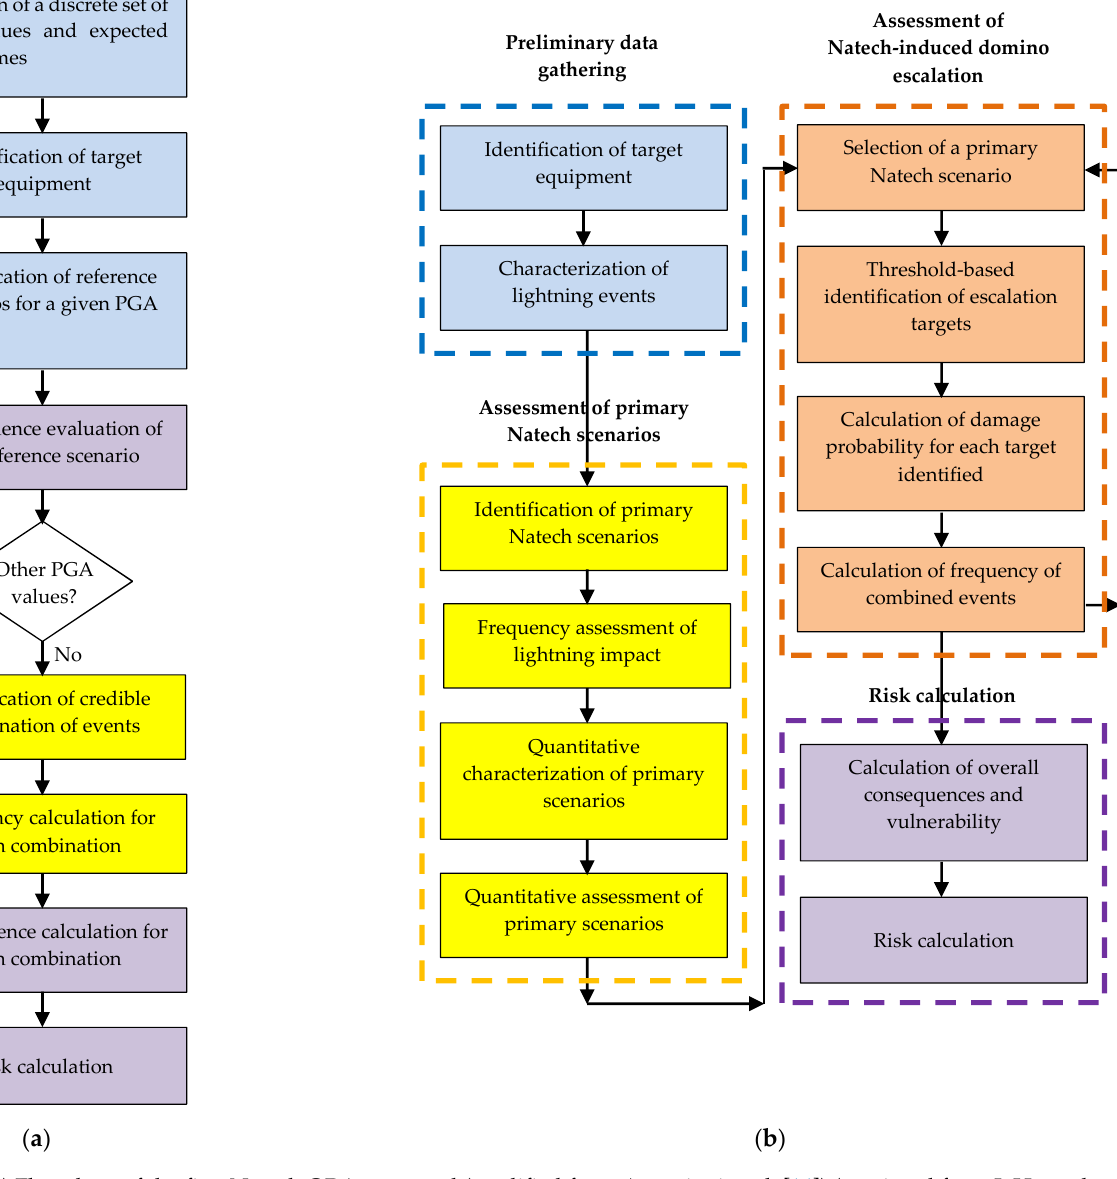
Figure 1. ( a ) Flowchart of the first Natech QRA proposed (modified from Antonioni et al. [14]) (reprinted from J. Hazard. Mater, 147, Antonioni, G., Spadoni, G., Cozzani, V. A methodology for the quantitative risk assessment of major accidents triggered by seismic events, 48-59, Copyright (2007), with permission from Elsevier.). ( b ) Flowchart of the last Natech QRA proposed (modified from Misuri et al. [20]) (reprinted from J. Loss Prev. Process Ind, 64, Misuri, A., Antonioni, G., Cozzani, V. Quantitative risk assessment of domino effect in Natech scenarios triggered by lightning, 104095, Copyright (2020), with permission from